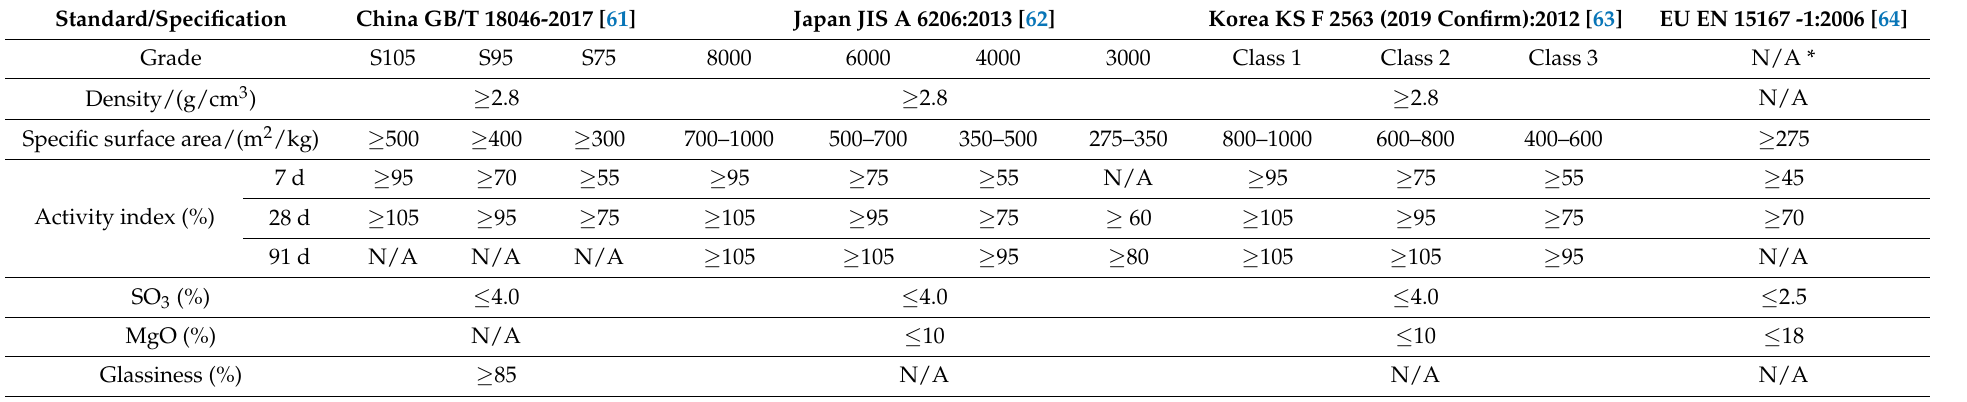
Table 2. Current typical slag standards in China, Japan, Korea, and the